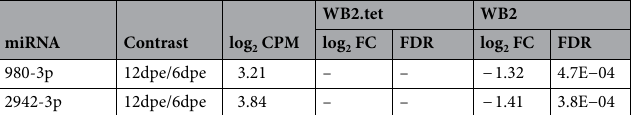
fold-change, suggesting some degree of consistency in their expression profiles. However, the effect of w AlbB on miRNA expression was weak, while the effect of age was robust, and showed reasonable concordance between lines. We validated the small RNA-Seq results using RT-qPCR by assessing nine w AlbB-modulated, and six age- modulated miRNAs that showed relatively high differential expression in small RNA-Seq. For w AlbB-modulated miRNAs, the degree of concordance between small RNA-Seq and RT-qPCR was satisfactory, with seven of the nine miRNAs showing agreement between the two methods in at least two age groups. Of the ten age-modulated miRNAs that we tried to validate, four were too lowly expressed in whole mosquitoes to allow sufficient ampli- fication by RT-qPCR. These were all miRNAs that were downregulated with age in the small RNA-Seq analysis